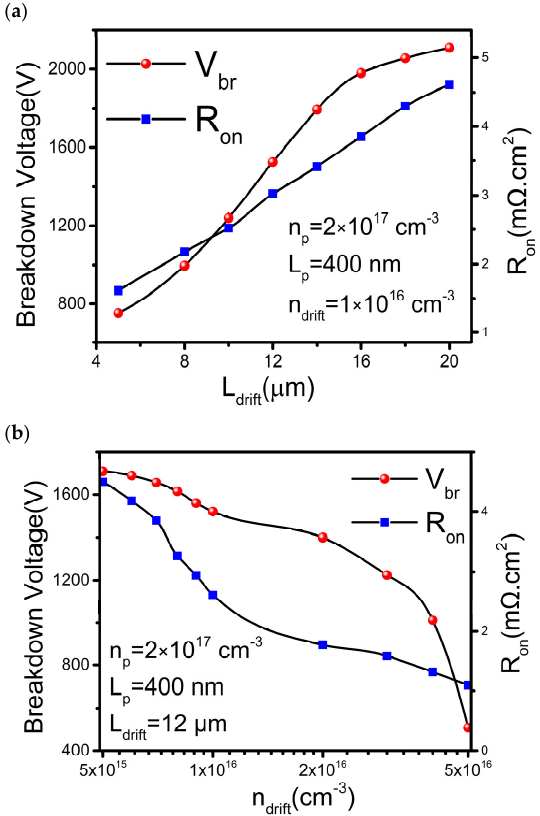
Figure 5. Optimization of V br with various parameters: ( a ) drift length (L drift ), ( b ) Drift doping con- centration (n drift ), with constant n p , L p and L drift at 2 × 10 17 cm − 3 , 400 nm and 12 µm respectively. Moreover, the p-type region is vital for switching performance and breakdown char- acteristics. Optimization is carried out by correlating n p to L p . Generally, a thicker p-layer with a higher doping concentration leads to an increase of channel resistance. It improves the breakdown voltage but the channel resistance increase slows down the switching op- eration. As plotted in Figure 6a, when n p increases, the V br increases linearly and saturates at n p around 2 × 10 17 cm − 3 . Similarly, the R on increases slowly until n p reaches 1 × 10 17 cm − 3 .